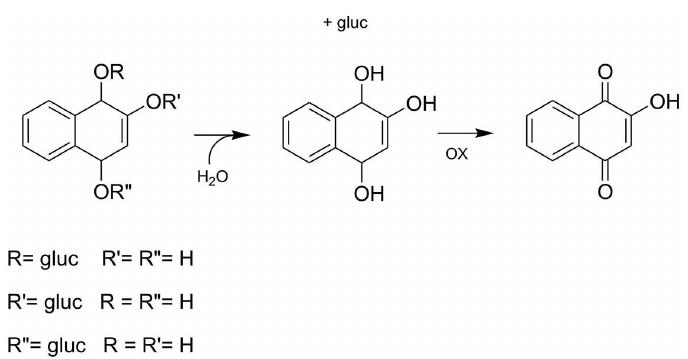
Figure 1. Conversion of hennosides (isomerglucosides) into lawsone